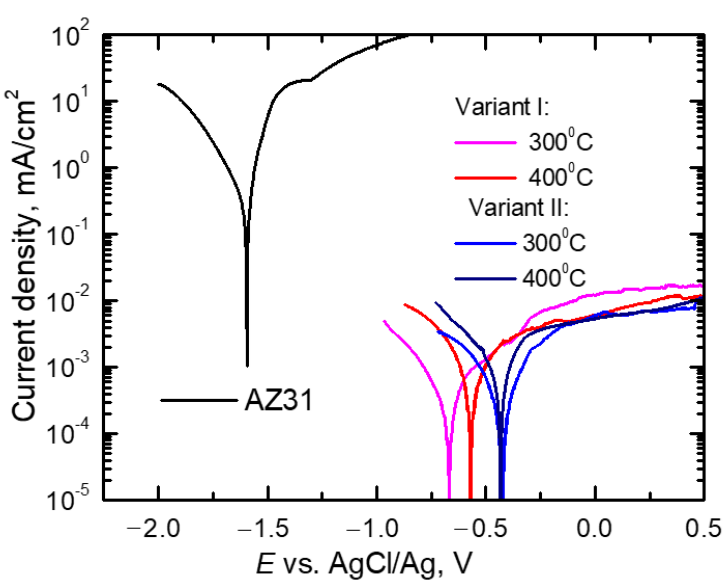
Figure 11. Potentiodynamic polarization curves for AZ31 and Mg/Al bimetals rolled at 300 °C or 400 °C for the classic (variant I) and modified system of grooves (variant II).